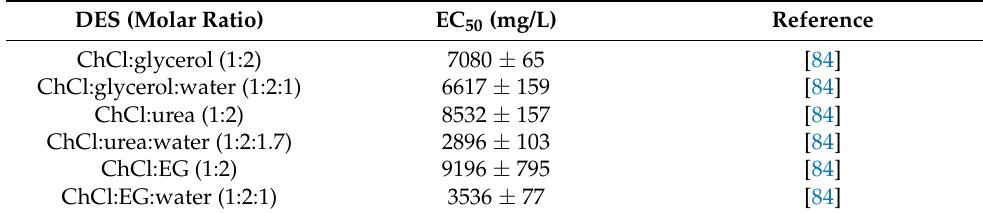
Table 5. Ecotoxicological data of some DESs in R. subcapitata .